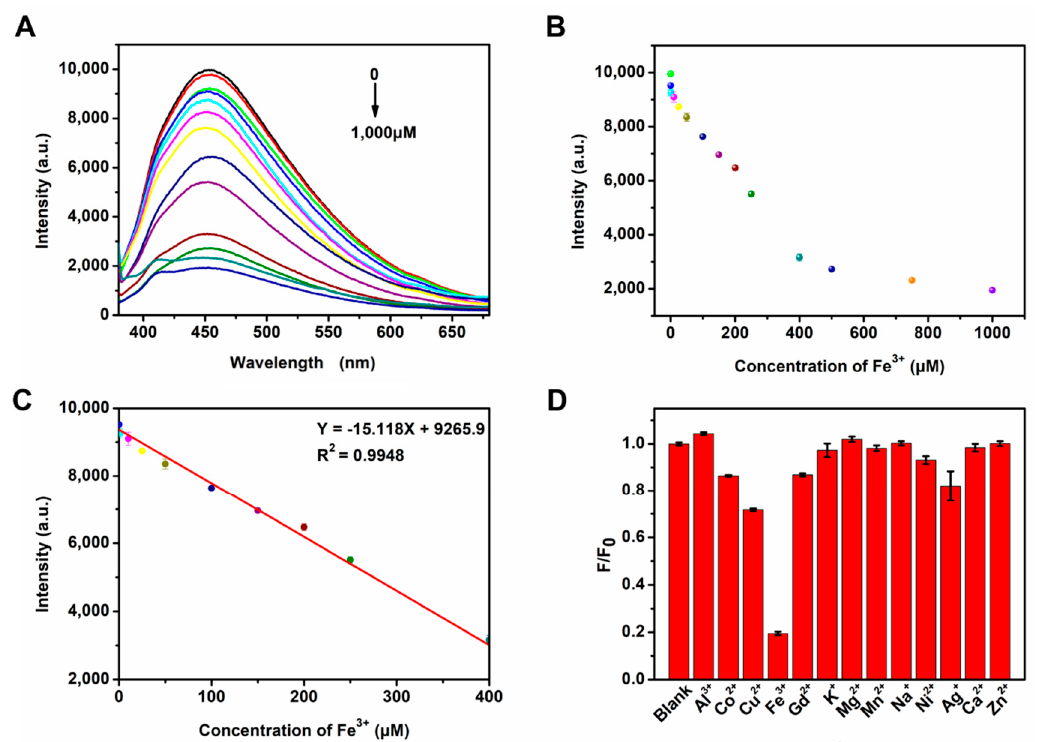
Figure 5. ( A ) Fluorescent emission spectra of N–CDs solutions with various concentrations of Fe 3+ (0–1000 µ M); ( B ) The fluorescence intensity change of N–CDs upon addition of various concentrations of Fe 3+ (from top to bottom: 0, 0.1, 1, 10, 25, 50, 100, 150, 200, 250, 400, 500, 750, 1000 µ M); ( C ) The linear calibration plot for fluorescence intensity versus different concentrations of Fe 3+ from 0.1 to 400 µ M; ( D ) The difference of fluorescence response (F/F 0 ) of N–CD solution in the presence of various representative metal